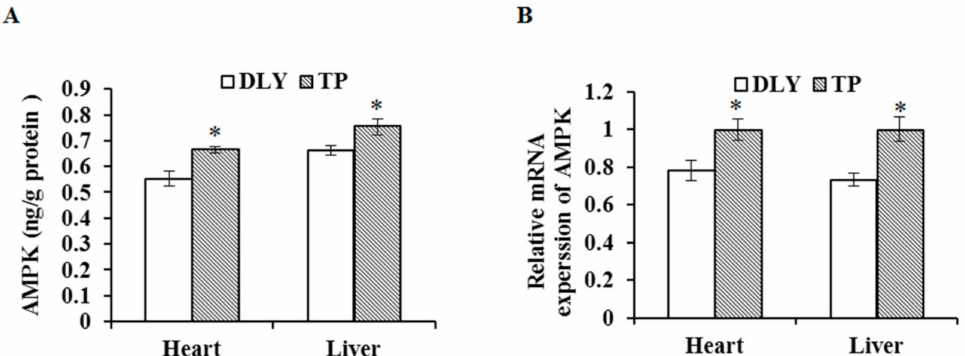
Figure 4. Effects of the plateau environment on protein ( A ) and mRNA ( B ) expression levels of AMPK in heart and liver of TPs and DLY pigs ( n = 12). * Significant difference ( p < 0.05). AMPK = adenosine 5 (cid:48) -monophosphate-activated protein